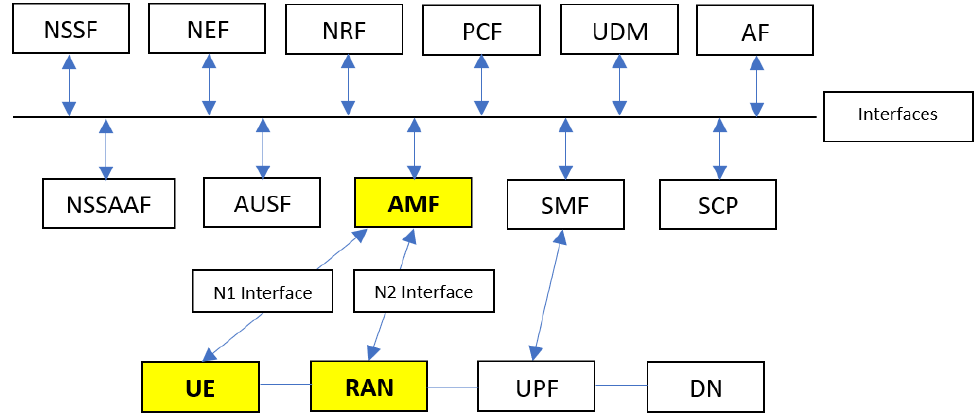
Figure 11. Non-roaming 5G